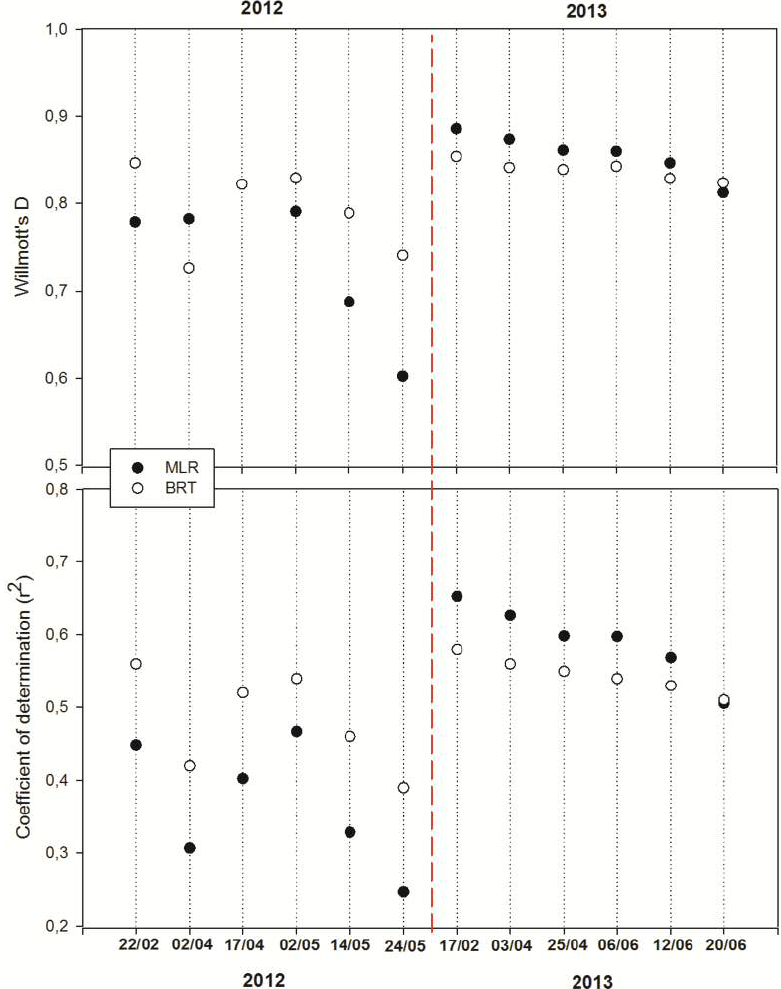
Figure 5. Willmott’s D and r 2 values between the observed and predicted SD, based on the multiple linear and binary regression models for all survey days.